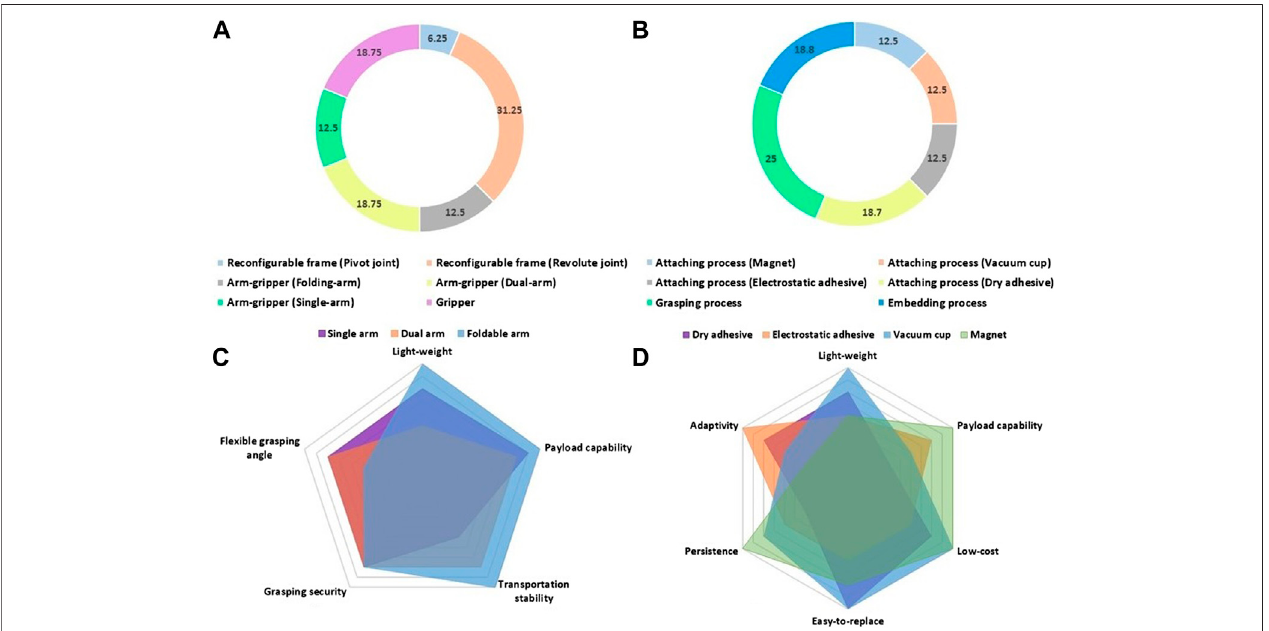
FIGURE 8 | A proportion analysis of the mentioned aerial robots with grasping and perching capabilities is demonstrated in the fi rst two sub- fi gures: Sub fi gure (A) presents the proportion analysis of mentioned aerial robots with grasping capabilities and (B) presents the proportion analysis of mentioned aerial robots with perching capabilities; A comparison of the mentioned mainstream grasping (arm-gripper) and perching (attaching) technologies is demonstrated in the last two sub- fi gures: (C) presents the comparison of different arm-gripper technologies across fi ve aspects including weight, payload capability, transportation stability, grasping security, and fl exibility of grasping angle and (D) presents the comparison of different attaching technologies across six aspects including weight, payload capability, cost, replaceability, persistence, and adaptivity.